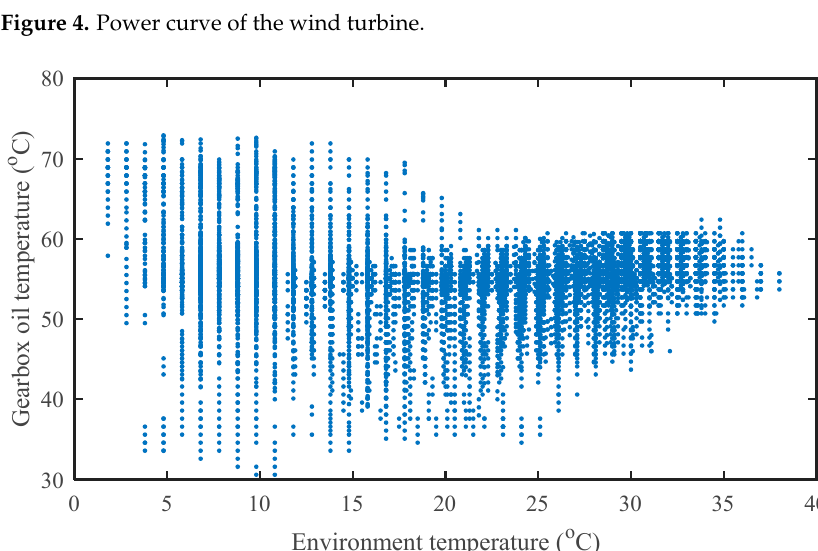
Figure 5. Relationship between the gearbox oil temperature and air temperature.